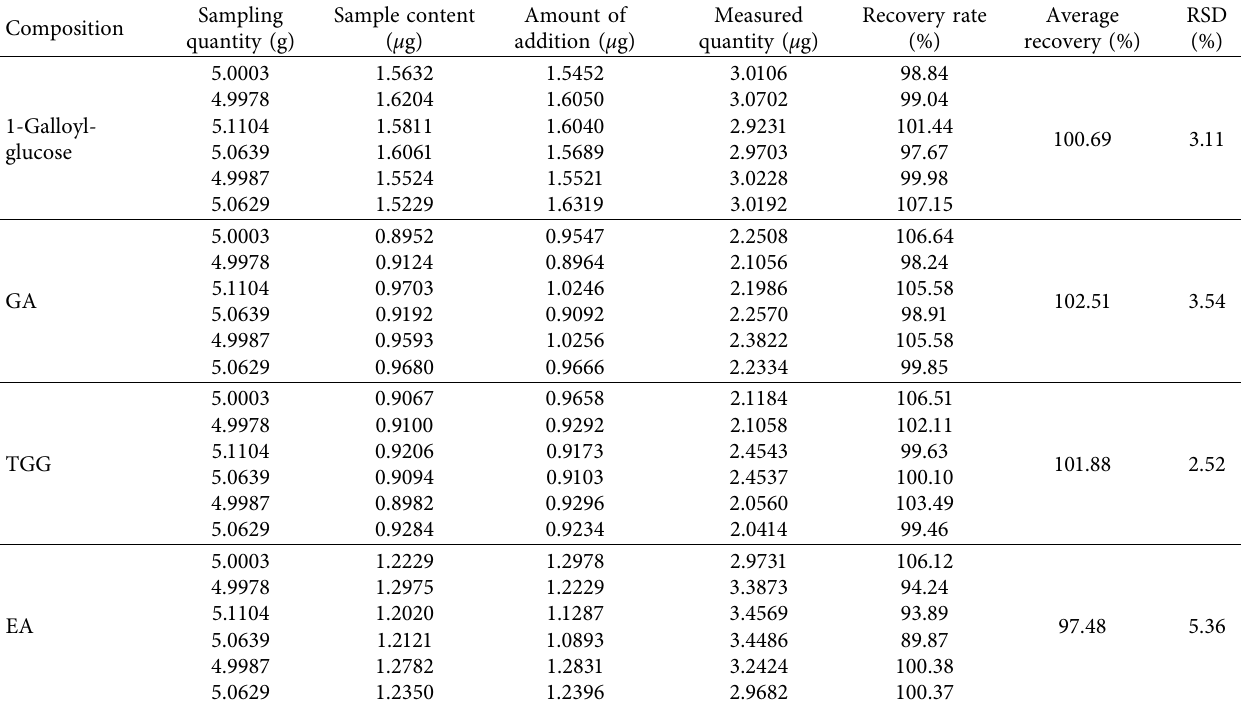
Table 2: Recovery of 1-galloyl-glucose, GA, TGG and EA from P. emblica .